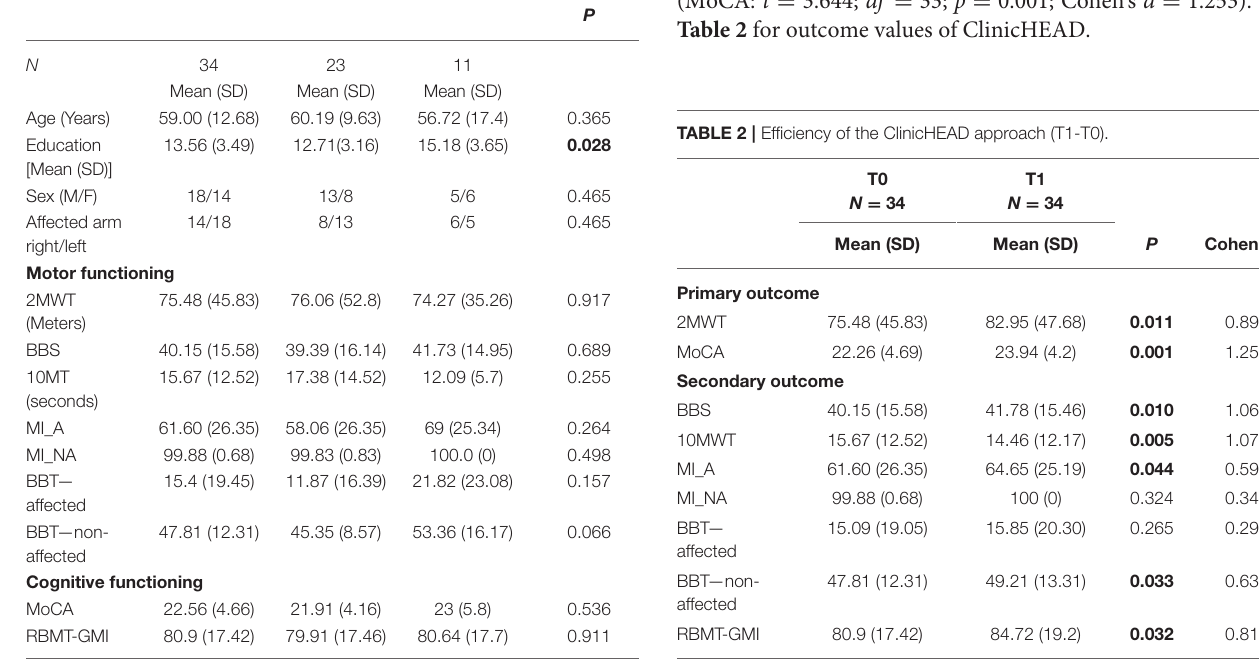
Table 2 for outcome values of ClinicHEAD.